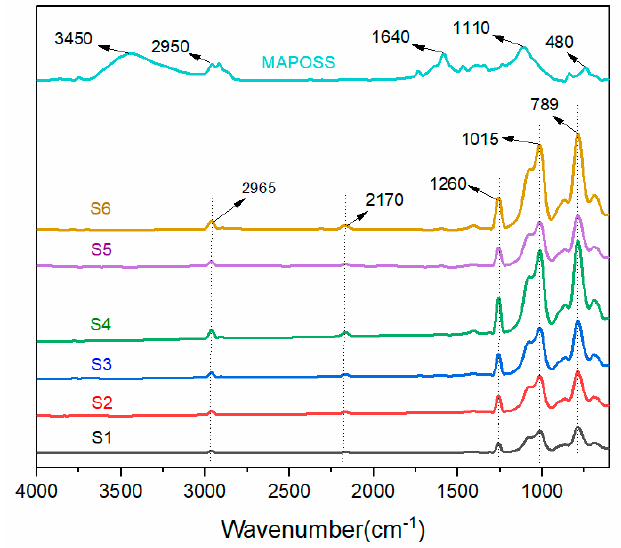
Figure 4. Fourier transform infrared spectrum of polysiloxane foams with di ff erent MAPOSS contents.